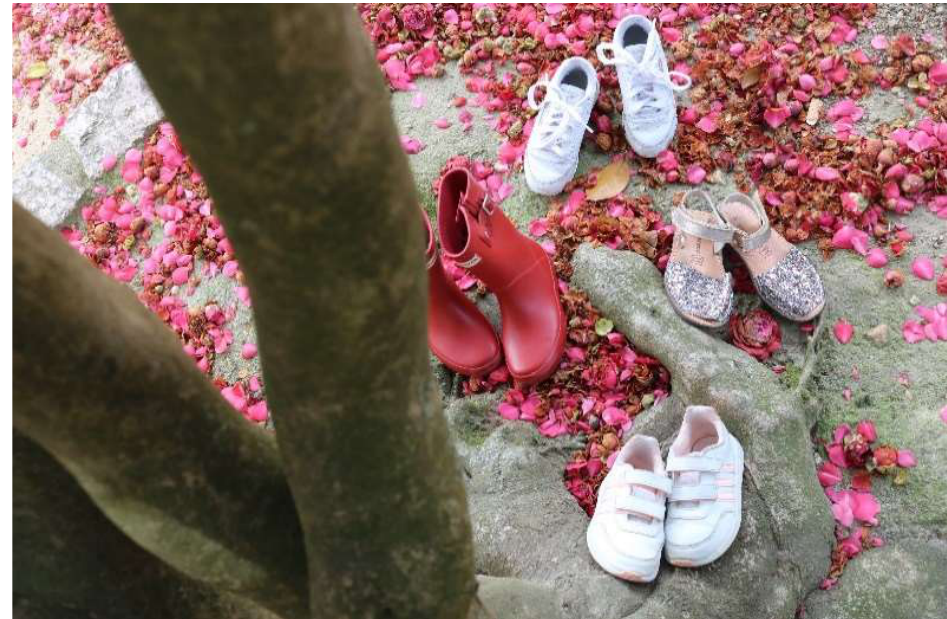
Figure 3. The Pass of time. Photography (PAES).